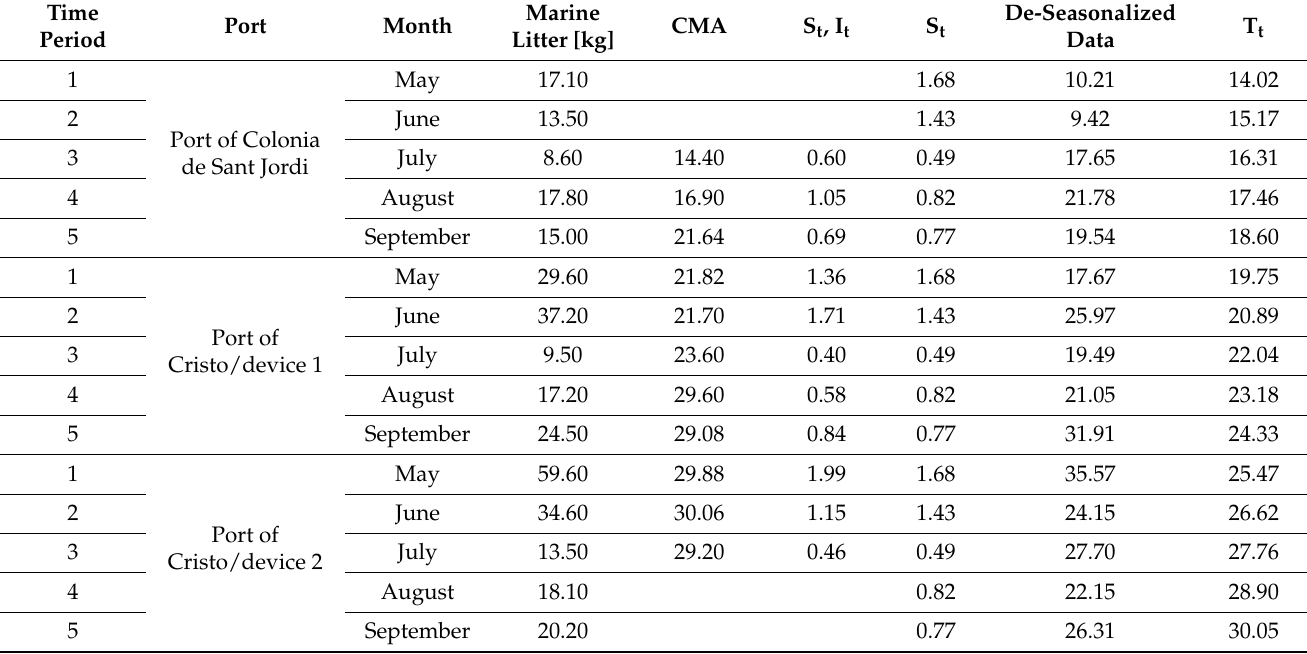
Table 4. Monthly time series analysis of the weight of marine litter collected at each site in 2021.